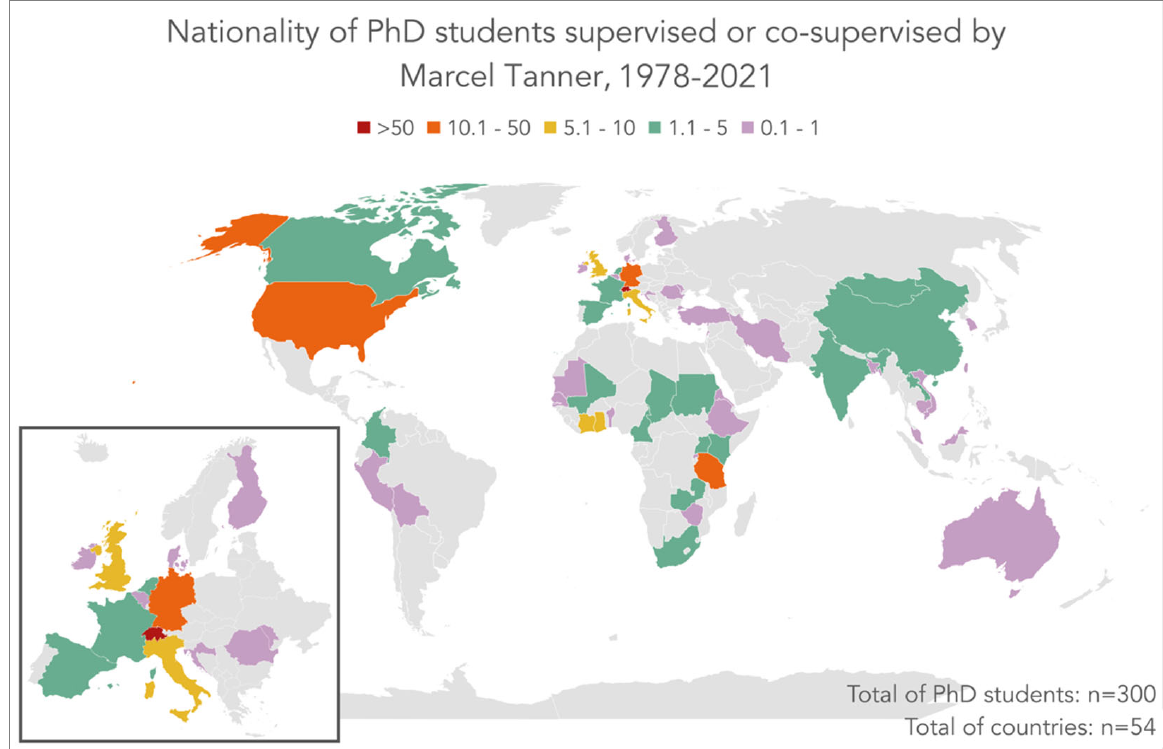
Figure 7. Nationality of Ph.D. students supervised or co ‐ supervised by Marce Tanner between 1978 and 2021.